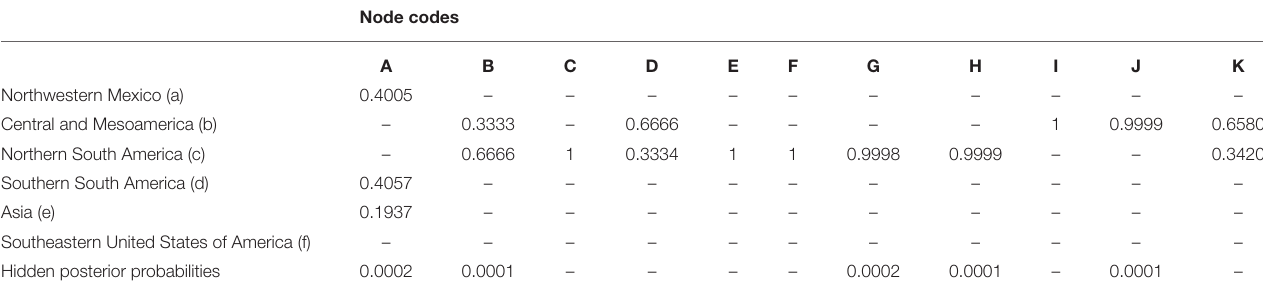
TABLE 1 | Reconstructed ancestral area probabilities for main clades within Hydrangea section Cornidia . Node codes correspond to those used in Figure 6